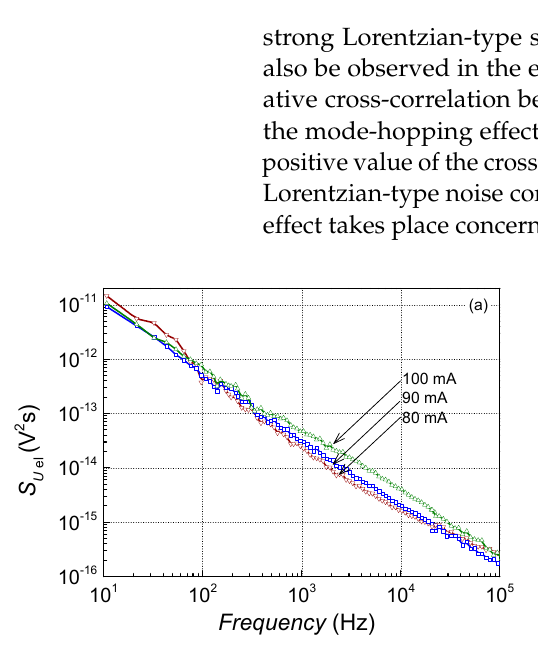
Figure 8. Electrical ( a ) and optical ( b ) noise spectra during the mode-hopping effect of sample No. 4 at room temperature.